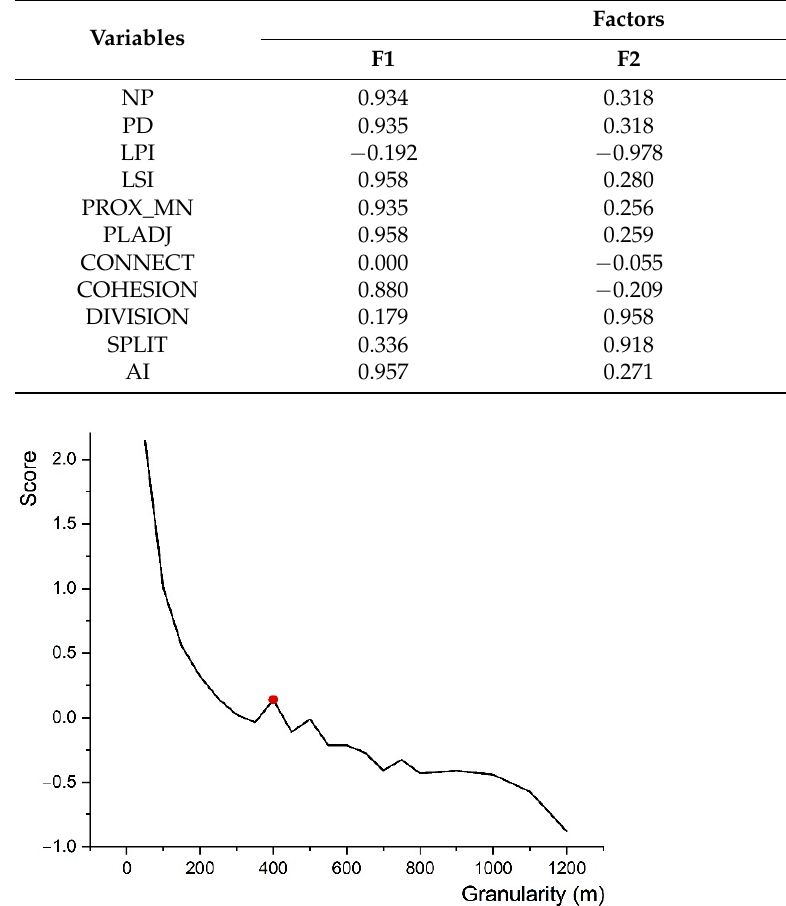
Table 7. Component matrix.